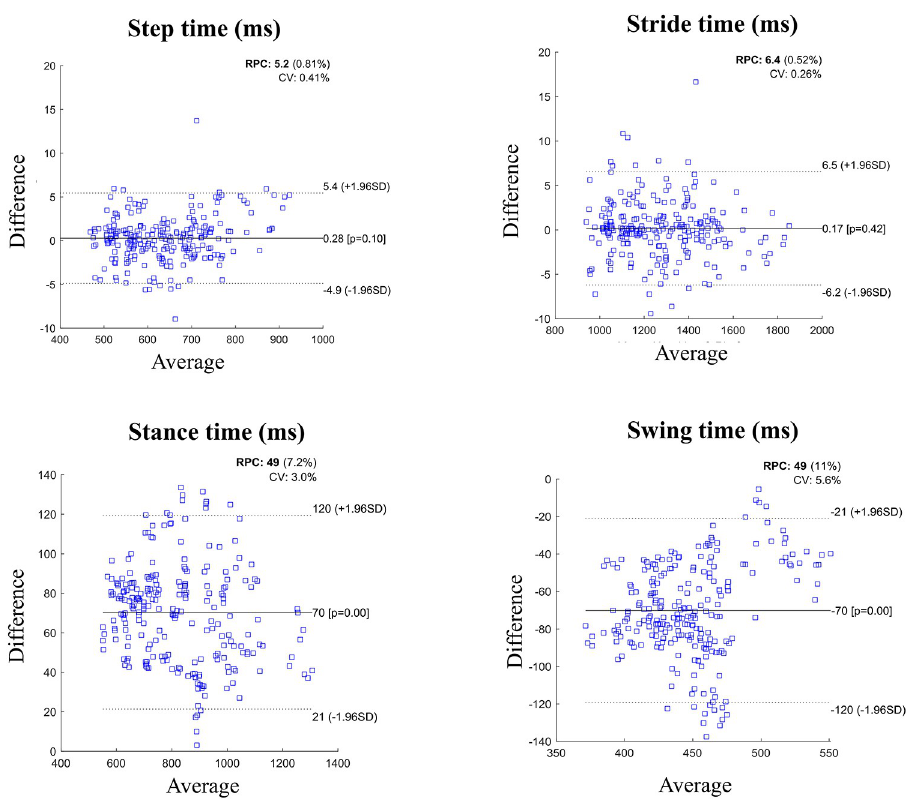
Fig 2. Bland Altman plots illustrating the agreement of four temporal parameters calculated using the algorithm- based method and those derived from the force-plate data. The average difference is specified by a solid line while limits of agreement ( ± 1.96SD) are represented by dotted lines. The figure files have also been provided in supplement to this article. RPC: Reproducibility co-efficient. CV: Coefficient of variation.